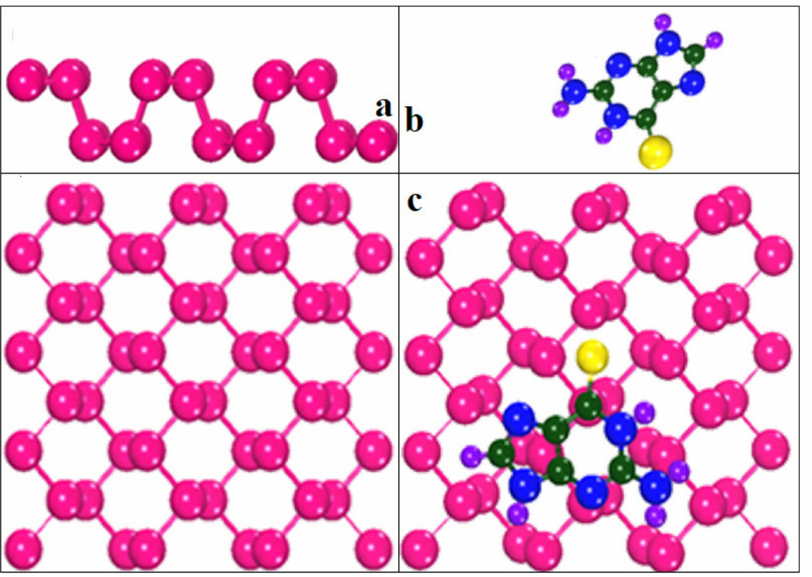
Figure 1. Optimized geometries of ( a ) phosphorene ( b ) thioguanine ( c ) phosphorene–thioguanine